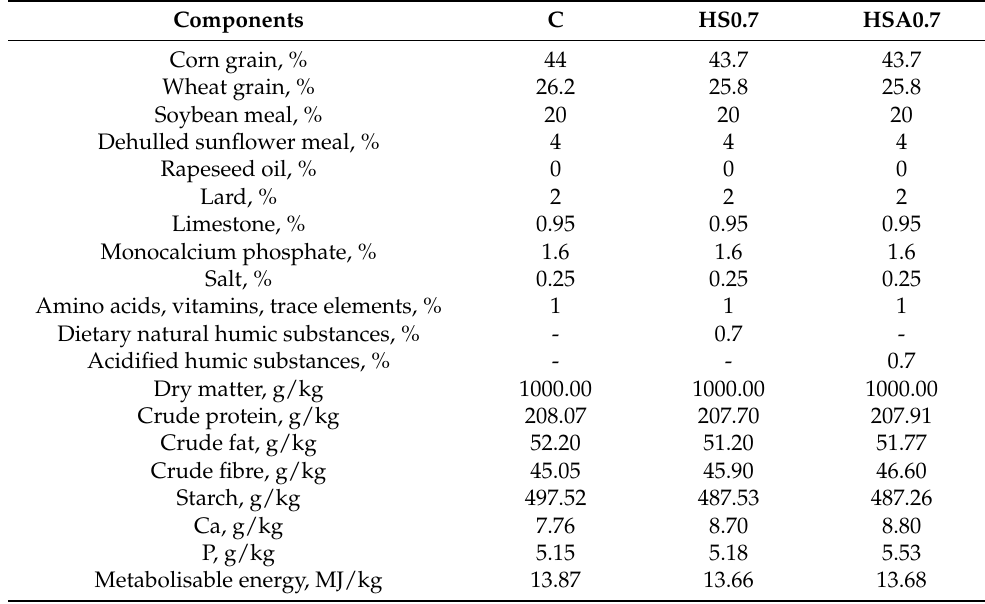
Table 2. The content of nutrients in final diet